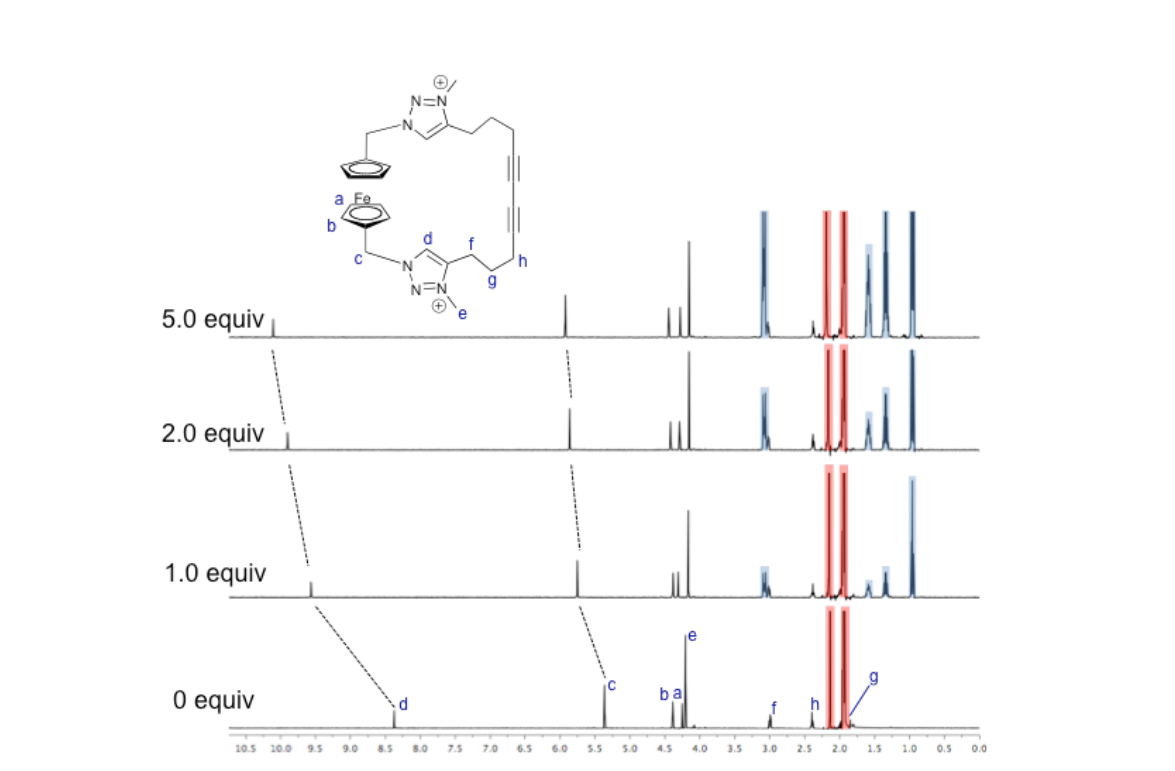
Figure 2: 1 H NMR spectra of 5 · 2PF 6 after the addition of 0, 1.0, 2.0 and 5.0 equiv of TBA·Cl (500 MHz, 293 K, CD 3 CN). Red-shaded peaks corres- pond to solvent signals (H 2 O and CH 3 CN); blue-shaded peaks correspond to signals from TBA cations.